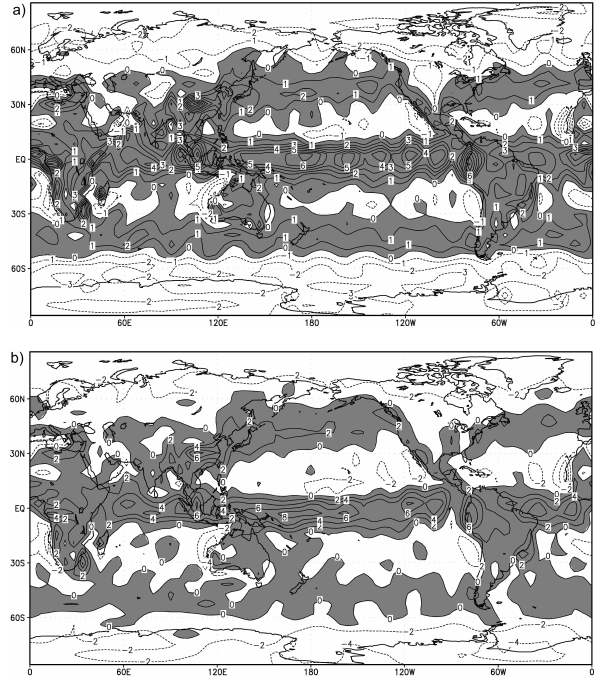
Fig. 4. Vertically averaged mean heating rates (in K/day) for the 100 (a) and 1000 (b) ppm CO 2 concentration